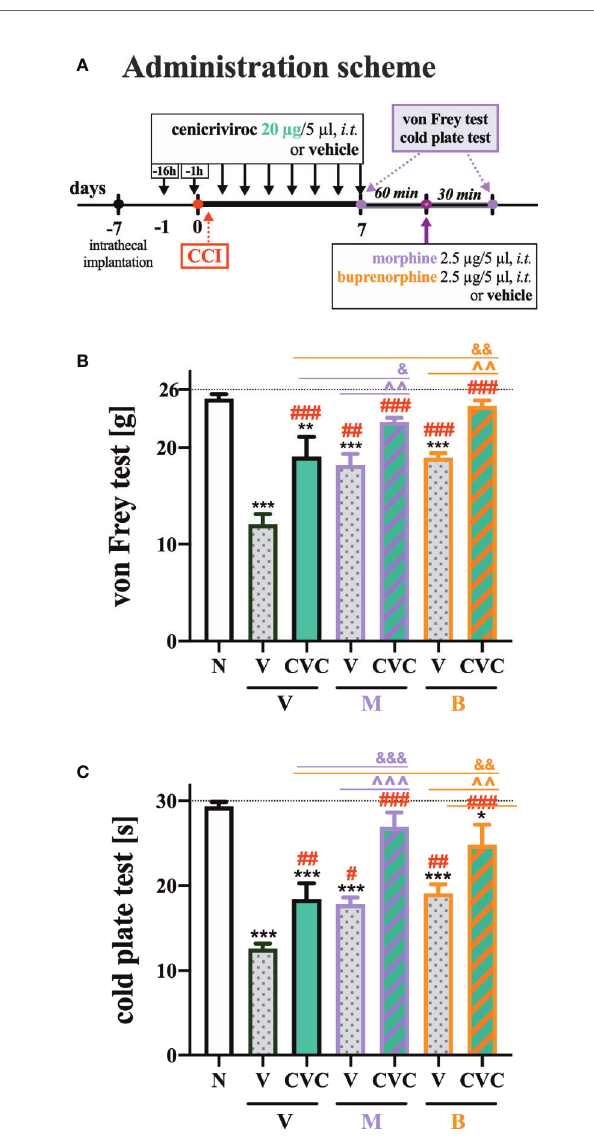
FIGURE 6 | The in fl uence of preemptive (16 h and 1 h before CCI) and then repeated i.t. administration of cenicriviroc in concentration of 20 µg/5 µl [ (A) administration scheme] on opioid effectiveness, as measured by the von Frey (B) and cold plate (C) test at 7 days post CCI. On day 7, 60 min after the last cenicriviroc ( CVC , 20 µg/5 µl) or vehicle ( V ) injection, rats received a single i.t. dose of morphine 2.5 µg/5 µl or buprenorphine 2.5 µg/5 µl. Behavioral tests were performed 30 min after opioid administration. The data are presented as the mean ± SEM (n = 6 per group). Intergroup differences were analyzed by ANOVA with Bonferroni ’ s multiple comparisons test. ***p < 0.001, **p < 0.01, *p < 0.05 indicate differences between naive and CCI-exposed rats; ### p < 0.001, ## p < 0.01, # p < 0.05 indicate differences versus V + V-treated CCI-exposed rats; &&& p < 0.001, && p < 0.01, & p < 0.05 indicate differences between CVC + V- and CVC+ M/ CVC+ B-treated, CCI-exposed rats; ^^^p < 0.001, ^^p < 0.01 indicate differences between V + M/V + B-treated and CVC + M/CVC + B-treated, CCI-exposed rats. The dotted line shows the cut-off value. B, buprenorphine; CCI, chronic constriction injury; CVC, cenicriviroc; M, morphine; N, naive; V,